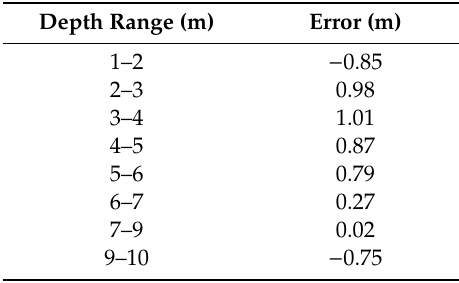
Figure 12. The relationship between SDB, obtained using log-band ratio method, and in-situ bathymetry acquired on the coast of San Vito Lo Capo.